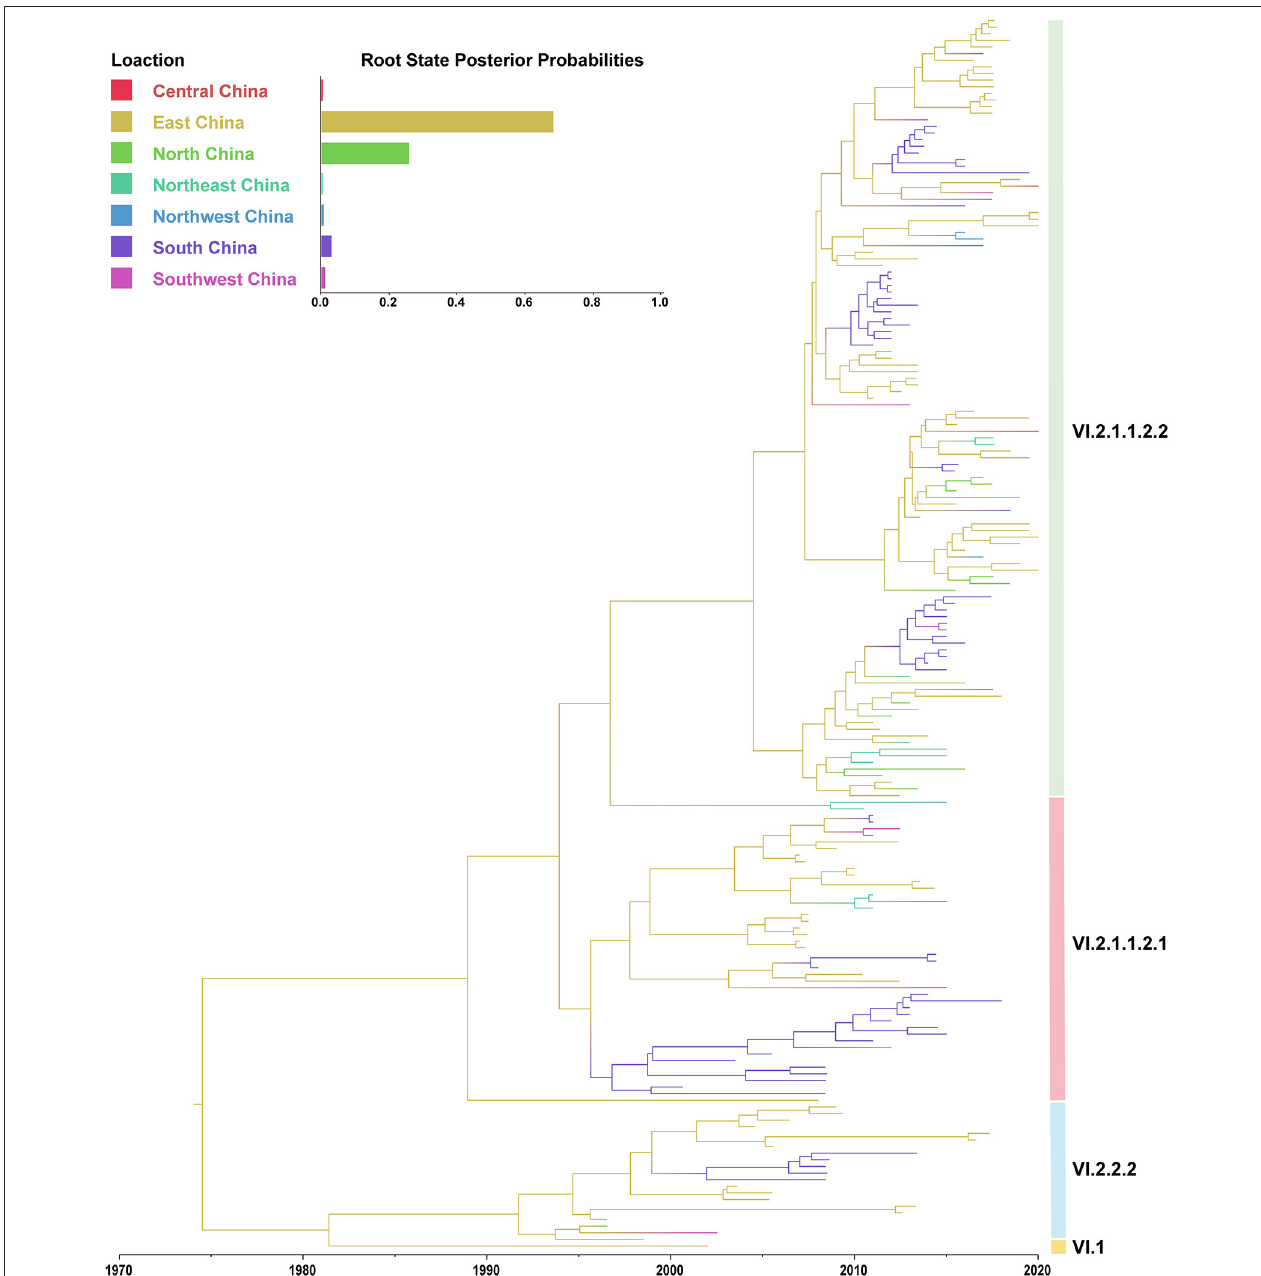
FIGURE 3 | A maximum clade credibility (MCC) tree of the complete F gene of PPMV-1 isolates circulating in China. The MCC tree was constructed using BEAST v.1.10.4. The root state posterior probabilities for seven different regions are exhibited in the embedded panel.